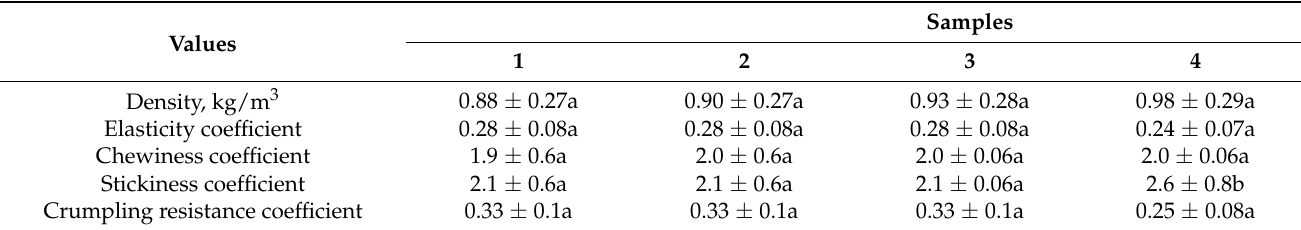
(Table 8) with 3% and 5% microalgae mixture additions had slightly better textural properties. Table 8. Texture of bread samples with